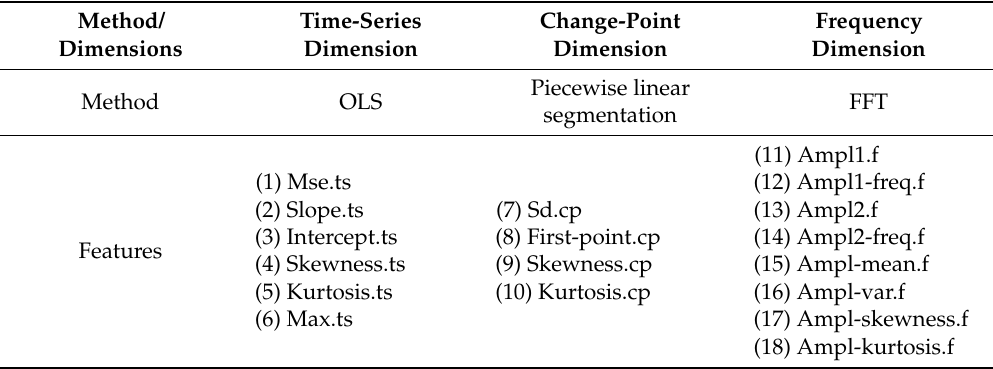
Table 3. Feature extraction from three dimensions.